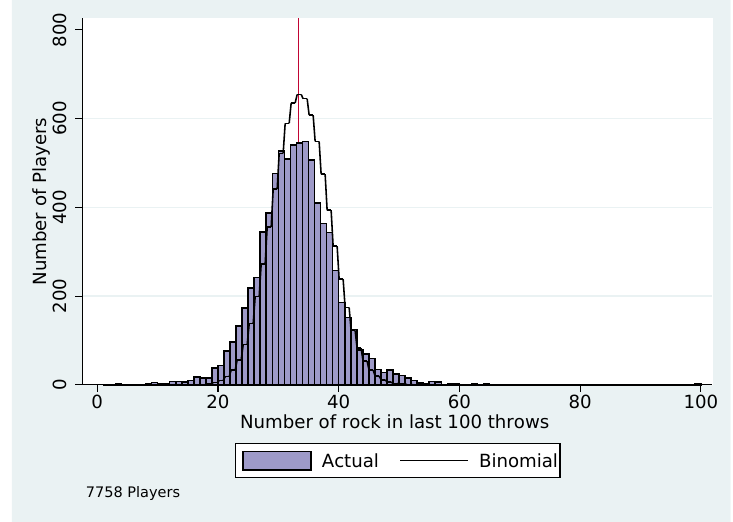
Figure 4. Percent of last 100 Throws that are Rock—Observed and Predicted. Note: For each of the 7758 players with at least 100 matches we calculate the percent of his or her last 100 throws that were rock (purple distribution). We overlay the binomial distribution with n = 100 and p = 1